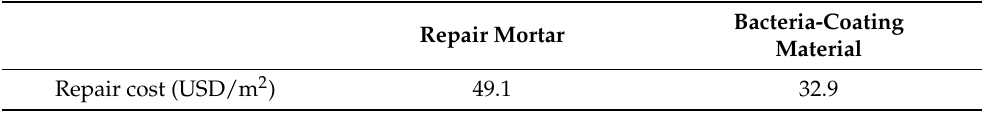
Table 8. Unit repair cost for each technique (thickness = 5 mm).